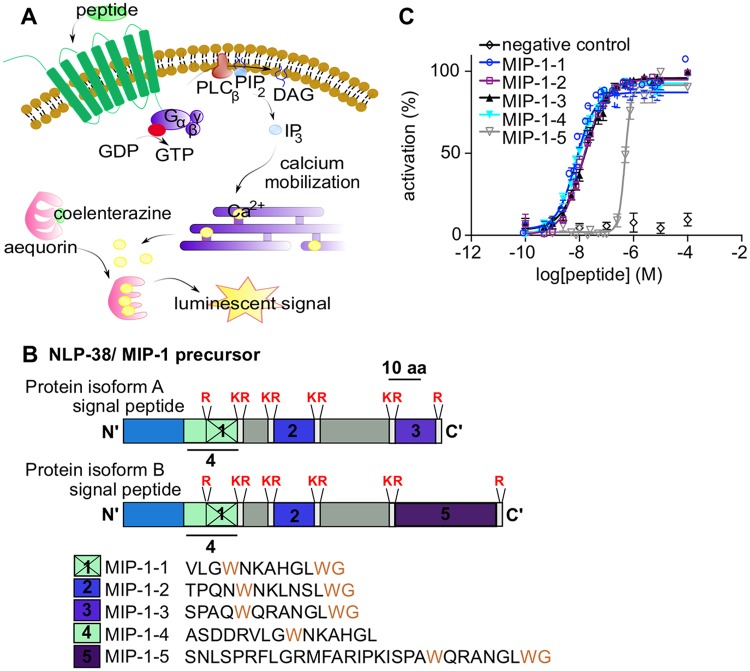
MIP-1 neuropeptides activate the MIP receptor ortholog SPRR-2.(A) Ca2+ luminescence assay for measuring GPCR activation. SPRR-2 is expressed in CHO cells that stably co-express the promiscuous Gα16 protein, which couples the receptor’s activation to the Ca2+ pathway. Intracellular Ca2+ levels are monitored by the luminescent Ca2+ indicator aequorin. (B) Domain structure of the C. elegans NLP-38 peptide precursor, henceforward named MIP-1. Gene models predict that the mip-1 gene encodes two protein isoforms (Wormbase WS261), MIP-1A and MIP-1B, which yield five putative MIP-1 peptides. Predicted proprotein convertase sites are indicated in red. Residues belonging to the W-X5-8-Wamide motif, typical of protostomian MIPs, are indicated in brown. (C) MIP-1 peptides dose-dependently activate SPRR-2. Ca2+responses of CHO cells expressing SPRR-2 are shown relative (%) to the highest value (100% activation) after normalization to the total Ca2+ response. EC50 values (95% CI) for MIP-1-1 to MIP-1-5 are 7.50 (6.21–9.01) nM, 14.19 (12.64–15.90) nM, 16.07 (13.65–18.91) nM, 8.32 (7.16–9.64) nM, and 486.41 (455.60–520.00) nM. Error bars show SEM (n ≥ 4).